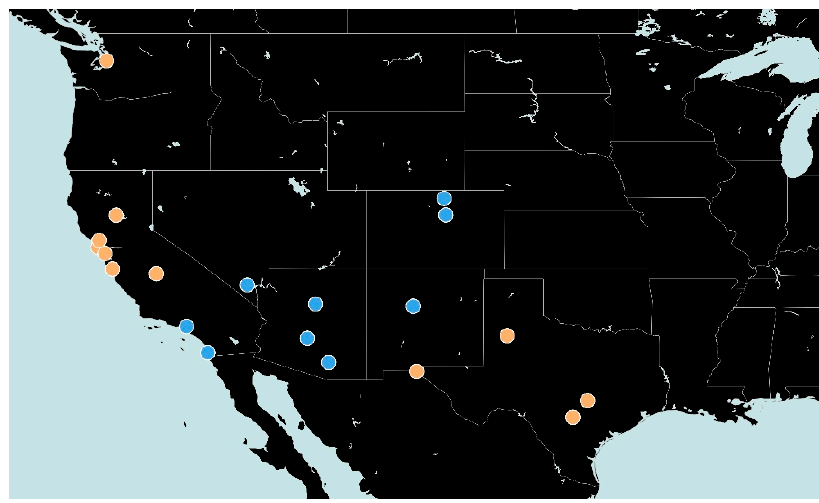
Figure 2. Twenty urban water utilities in the western US were surveyed in this study. Cities served with water from the Colorado River basin are indicated by blue dots. All cities are identified by name and state in Table 1.